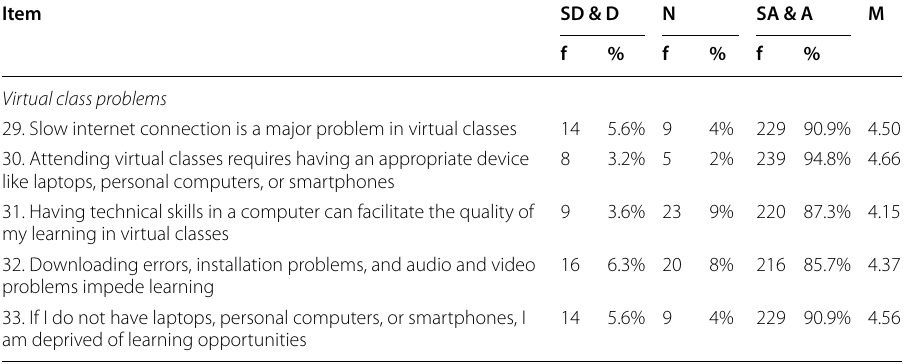
Table 11 Frequency, percentage, & mean score for students’ responses to APPRSQ (virtual class problems)